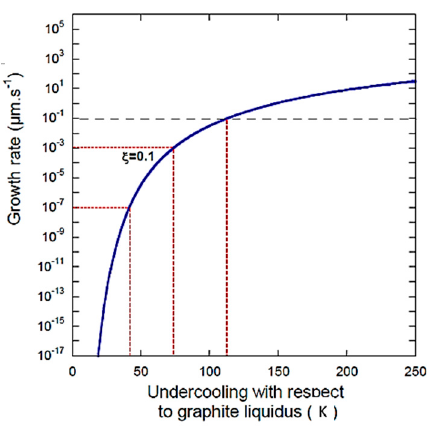
Figure 2. Growth rate according to the PNG model of Equation (5), as a function of undercooling (Figure 1b in ref. [1], Figure 5 in ref. [3]) showing data selected for the calculation in Table 1. The third and final objection in the Comment [1] refers to the use of adjustable parameters.